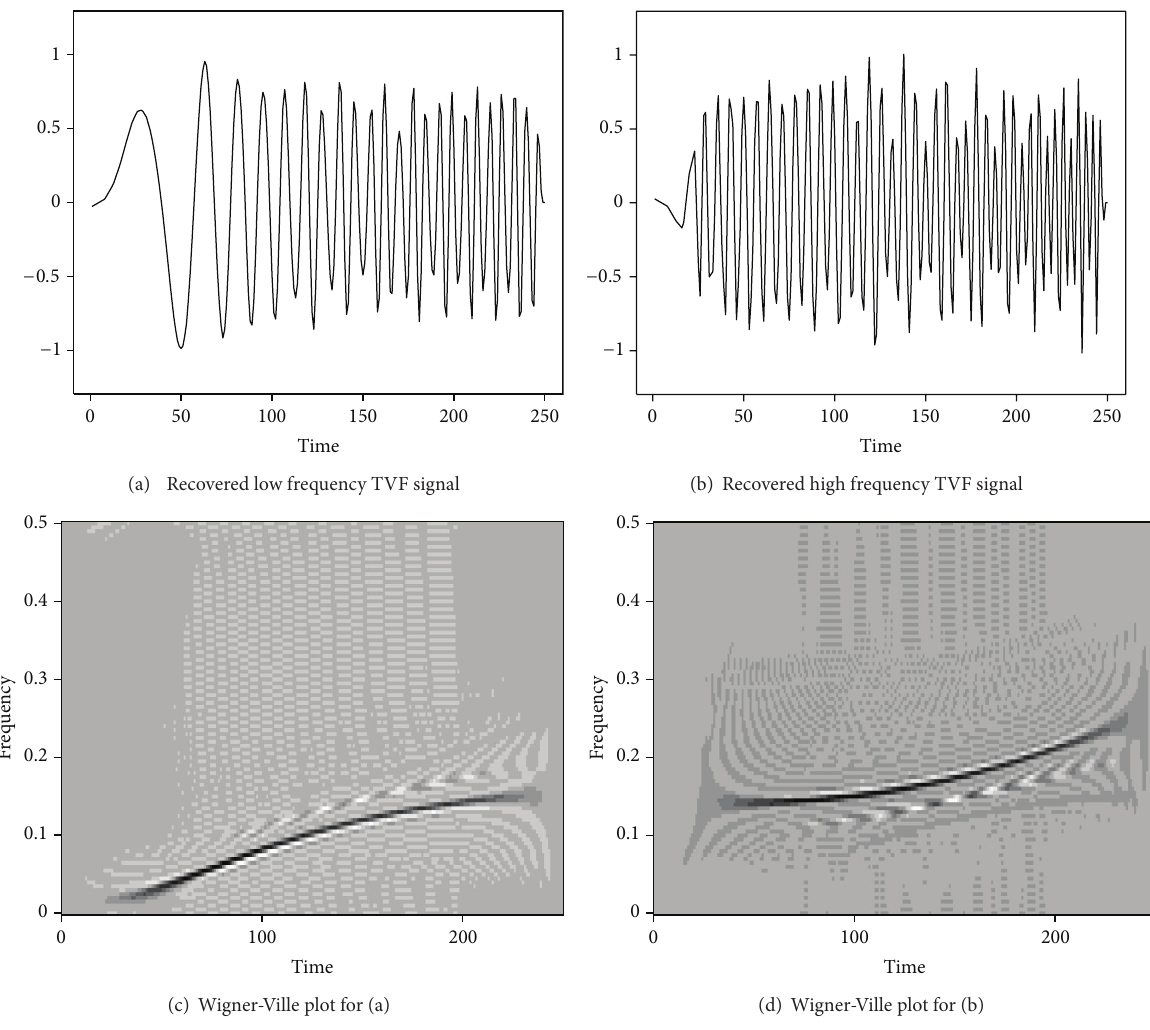
Figure 6: (a) Figure 5(c) plotted on original time scale; (b) Figure 5(d) plotted on original time scale; (c) Wigner-Ville plot for data in (a); (d) Wigner-Ville plot for data in